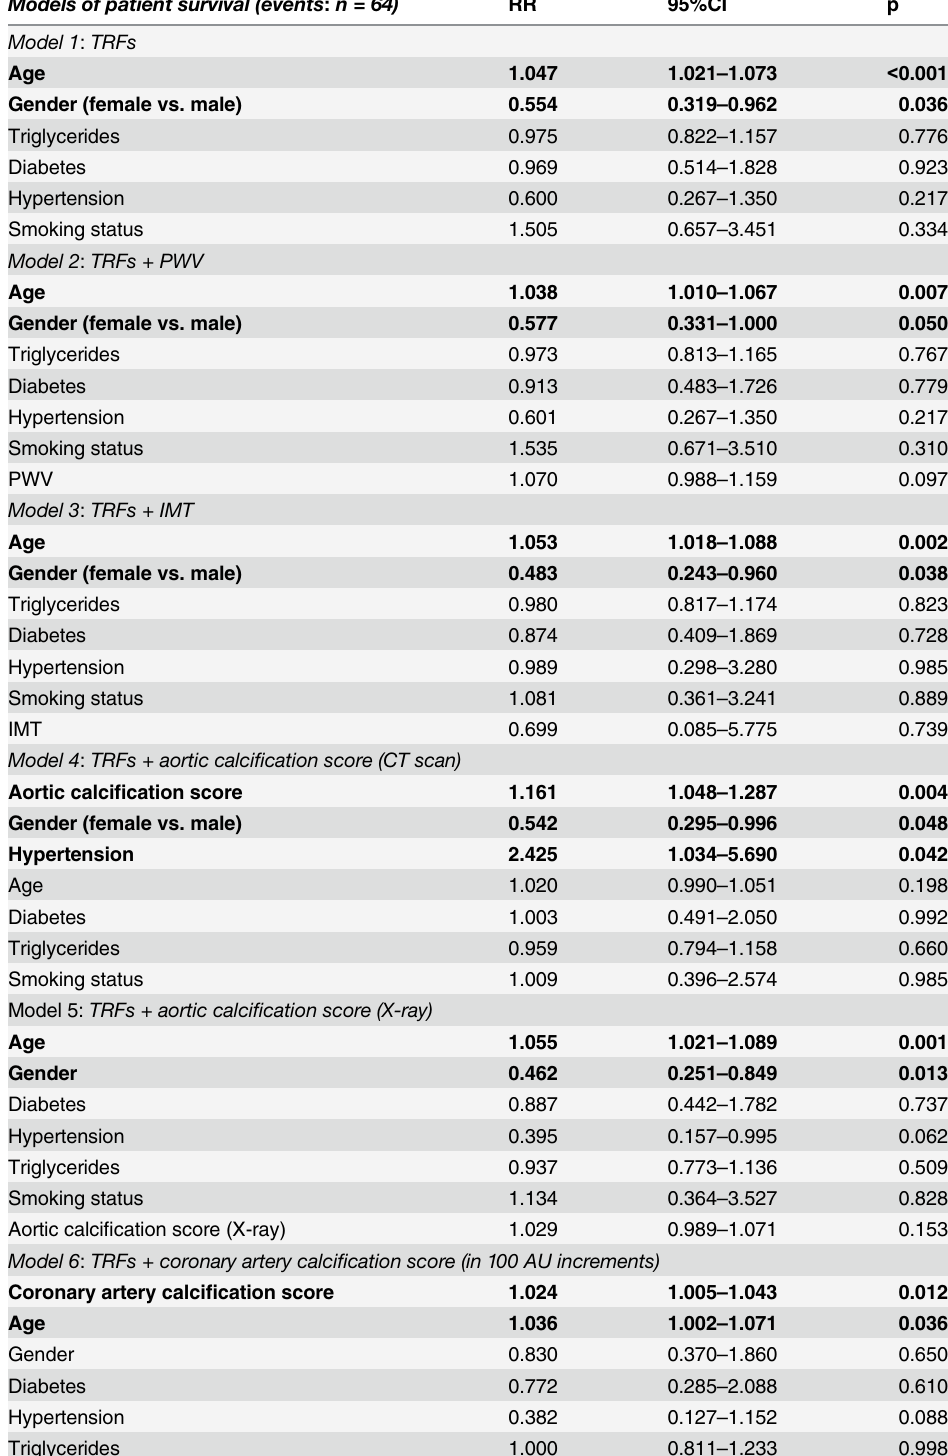
Table 3. Multivariate Cox regression analysis of risk factors at baseline for all-cause mortality and first non-fatal CV events. Models of patient survival (events : n =